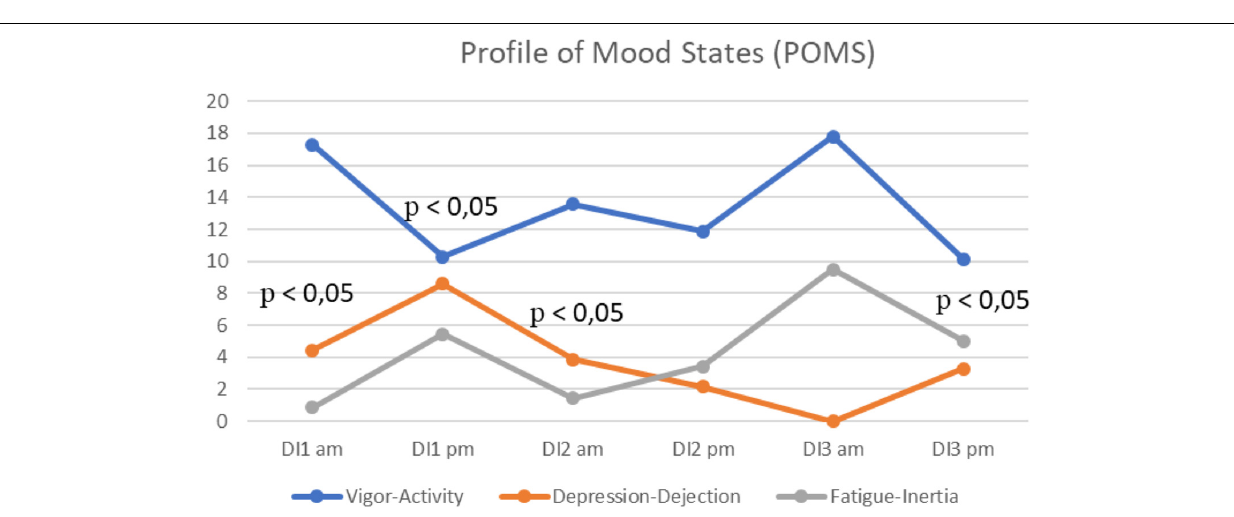
FIGURE 4 | Average mood states (Vigor-Activity, Depression-Dejection and Fatigue-Inertia) per morning/evening during the 3-days “dry” immersion experiment. Mean ±